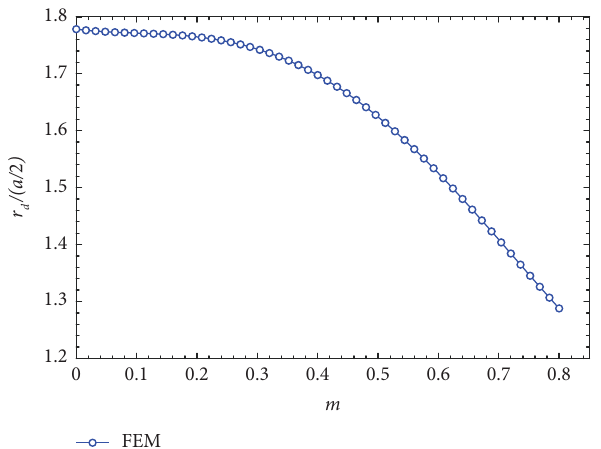
Figure 12: Breakout failure normalized depth versus eccentricity.